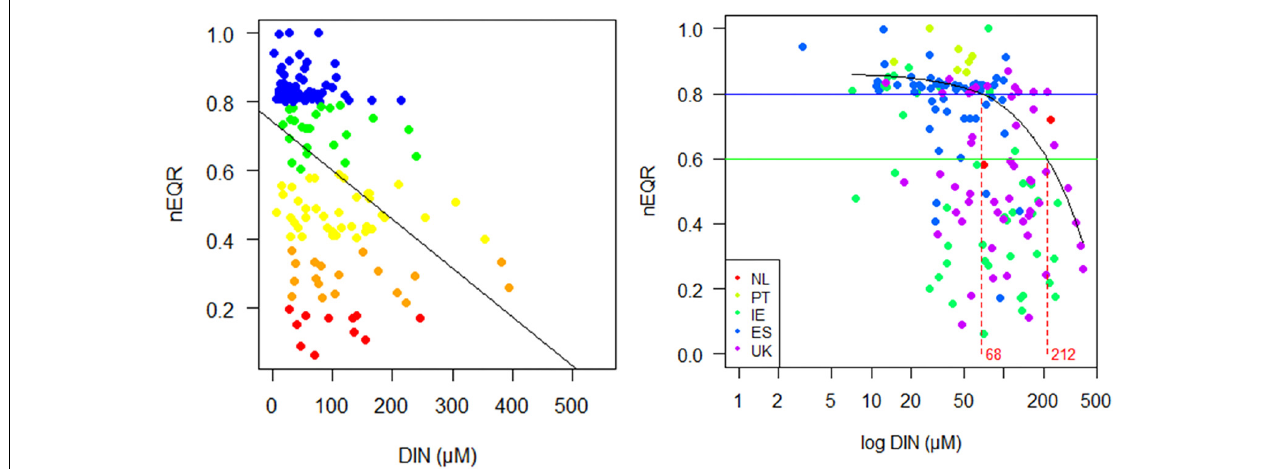
FIGURE 5 | Relationship of nutrient Dissolved inorganic nitrogen (DIN) concentrations ( µ M) with intercalibrated normalized nEQRs in the NE Atlantic estuaries (NEA11 common type), including observations from Netherlands (NL), Portugal (PT), Ireland (IE), Spain (ES) and the United Kingdom (UK): (left) scatter plot and linear trend, with sites colored according to ecological status (High, blue; Good, green; Moderate, yellow; Poor, orange; Bad, red) and (right) quantile regression fit (Additive Quantile Regression Smoothing rqss using quantreg R package by Koenker) for nEQR v DIN ( µ M), where horizontal lines indicate EQR boundaries at H/G and G/M, and vertical lines the nutrient boundaries, respectively for H/G and G/M, at the 70th quantile.